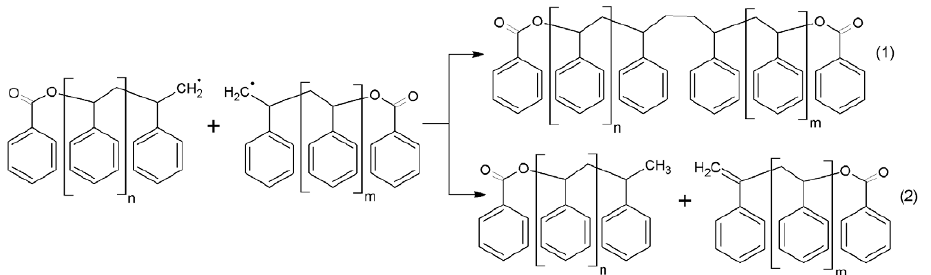
Scheme 6. Schemes of chain termination in case of initiated